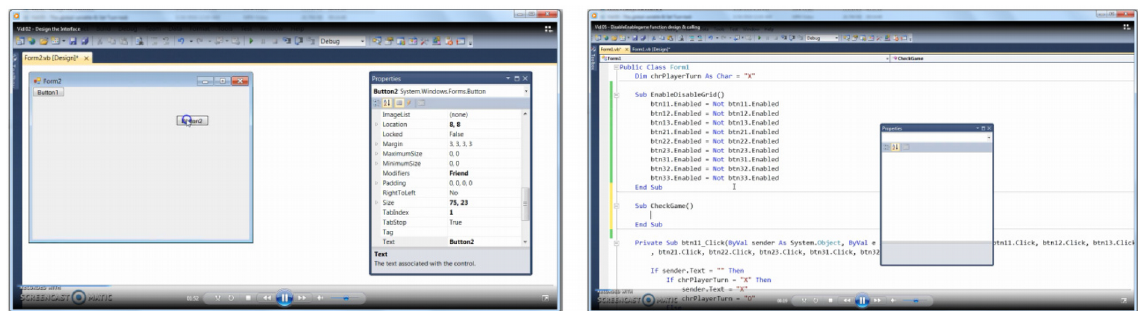
Figure 2. Snapshots of video